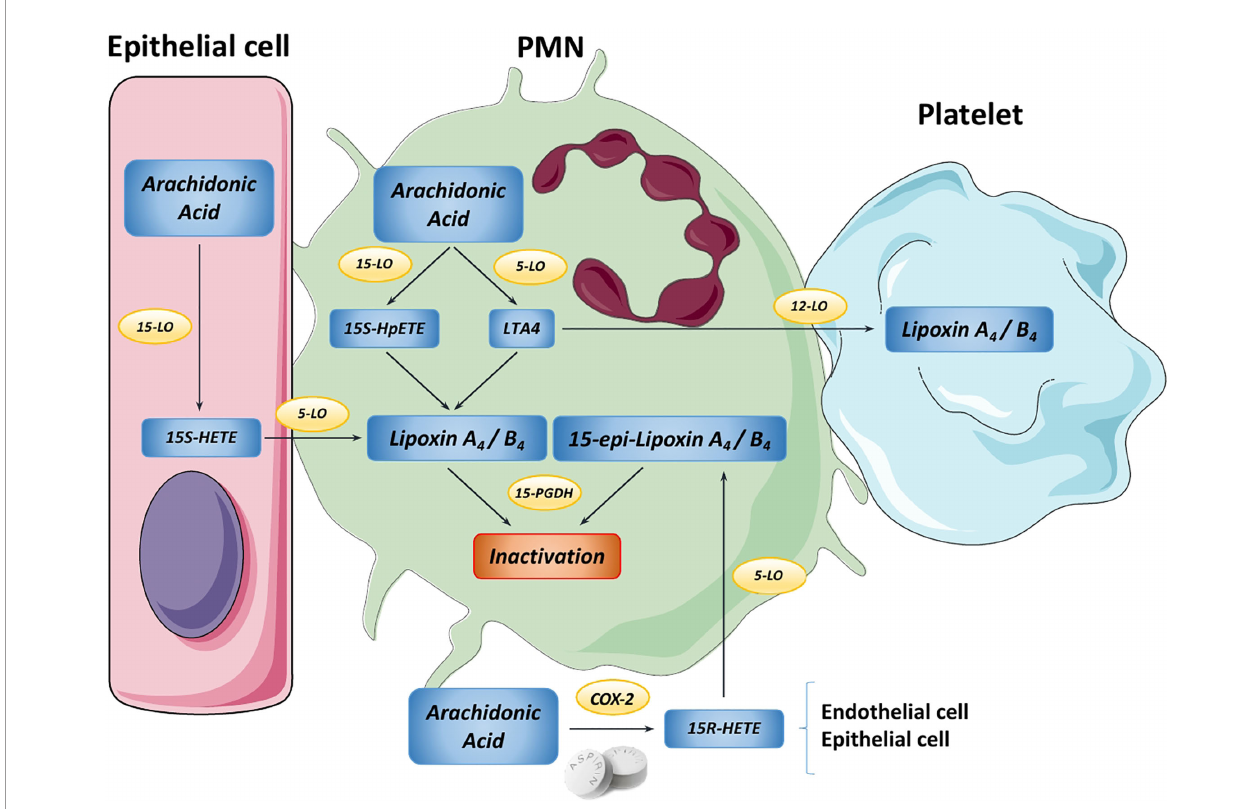
FIGURE 2 | Overview of the main lipoxin biosynthetic pathways. In the PMN cell, Arachidonic Acid (AA) can be converted into either 15S-HpETE or Leukotriene A 4 (LTA4) by 15-LO and 5-LO, respectively. Then, these metabolites are transformed into native lipoxin A 4 or B 4 . Moreover, platelets can use LTA 4 from PMNs to produce LXA 4 /B 4 in a process known as transcellular biosynthesis. Likewise, in epithelial cells AA is transformed by 15-LO into 15-HETE, which is transferred to PMNs to produce LXA 4 /B 4 . Endothelial cells can use AA to yield the intermediate 15R-HETE by COX-2, step that is promoted by aspirin. This transitional molecule is metabolized by PMNs to generate the “ aspirin-triggered ” 15-epi-lipoxins A 4 and B 4 . Finally, both native and aspirin-triggered LXs can be rapidly inactivated by 15- PGDH, stopping the downstream